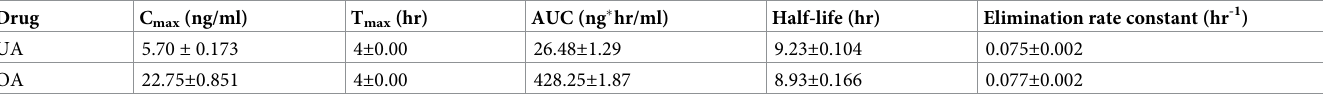
Table 1. Pharmacokinetics parameters of UA and OA administered through MDI (240 μ g/kg BW) in Wistar rats. Drug